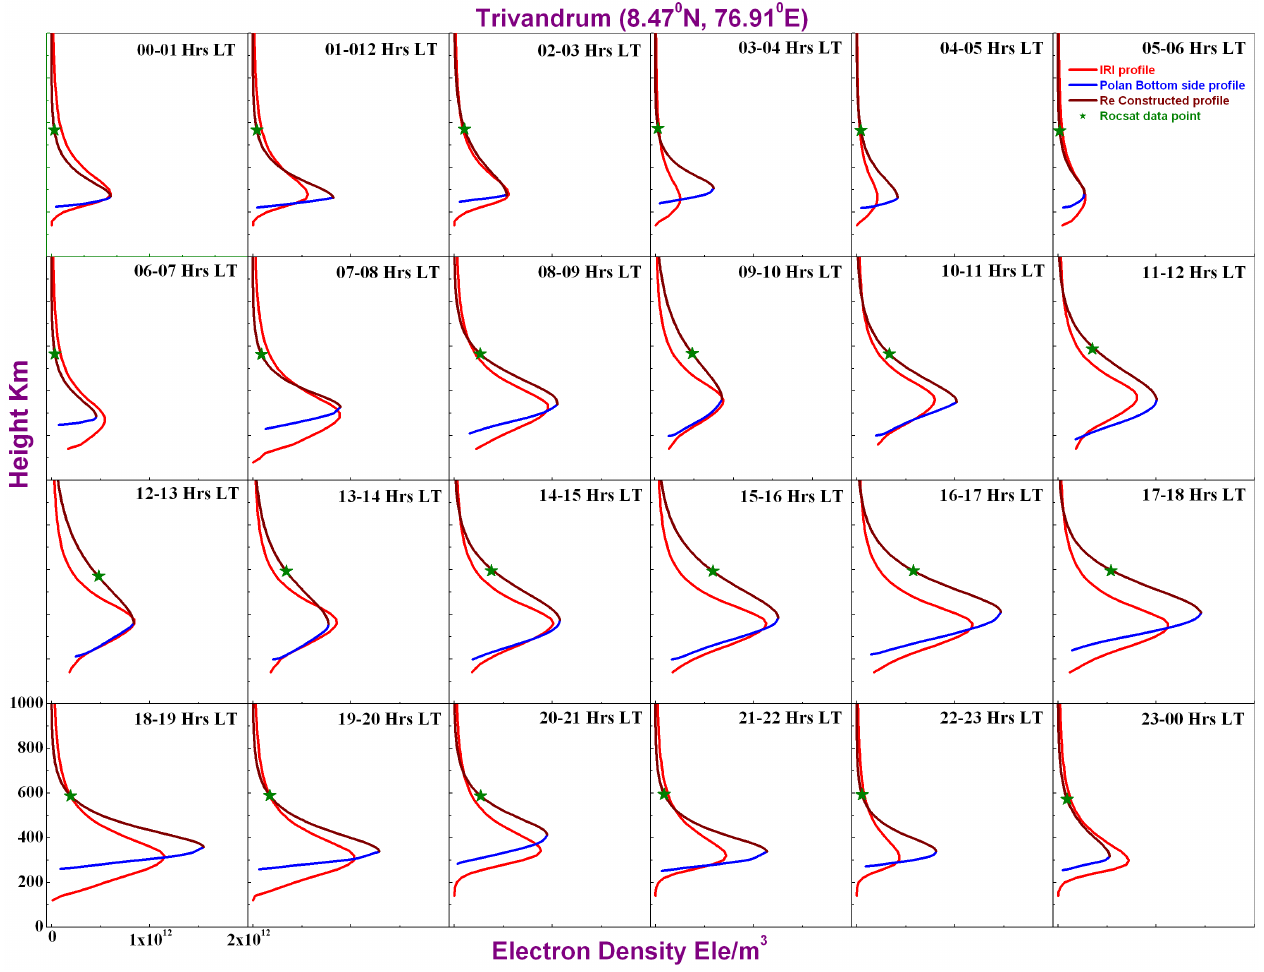
Fig. 4. Vertical electron density profiles reconstructed using ionosonde and ROCSAT data along with the simultaneous IRI model derived profiles for all the hours of the day over an equatorial station